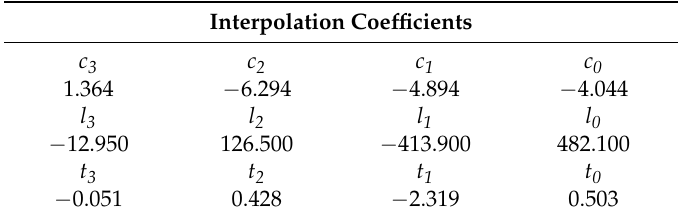
Table 3. Polynomial interpolation coefficients for the circuit element values C , L , and θ.